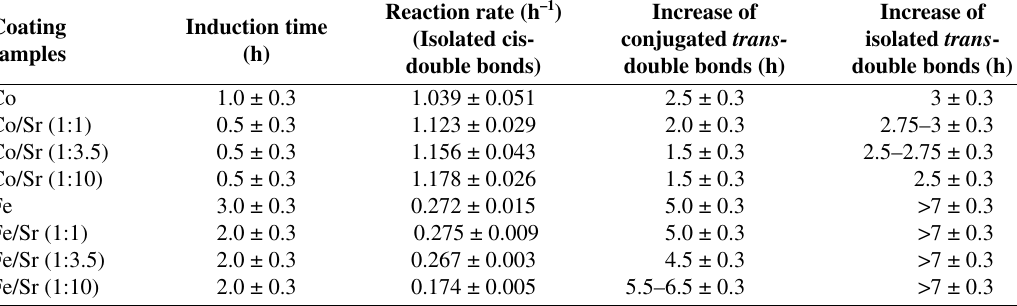
Table 1. FT-IR related data.